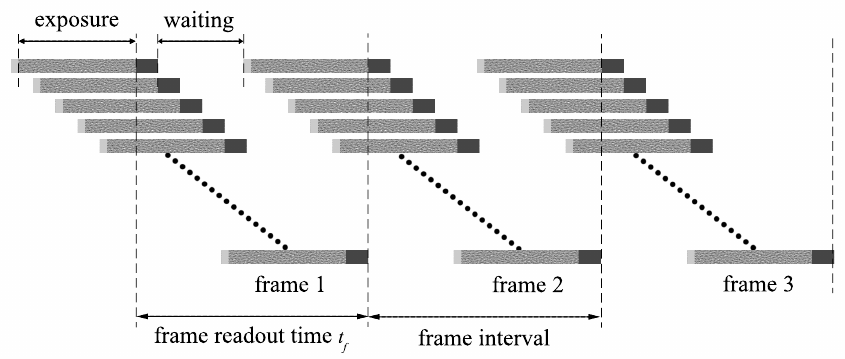
Figure 2. Image acquisition in multiple